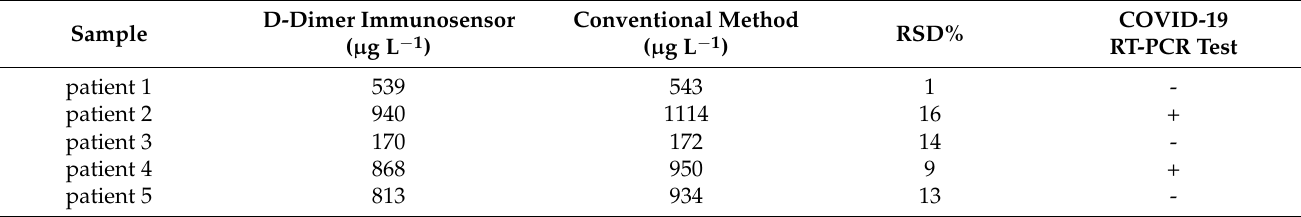
Table 3. D-dimer determination in human plasma samples using the proposed immunosensor and a conventional immunoturbidimetric reference